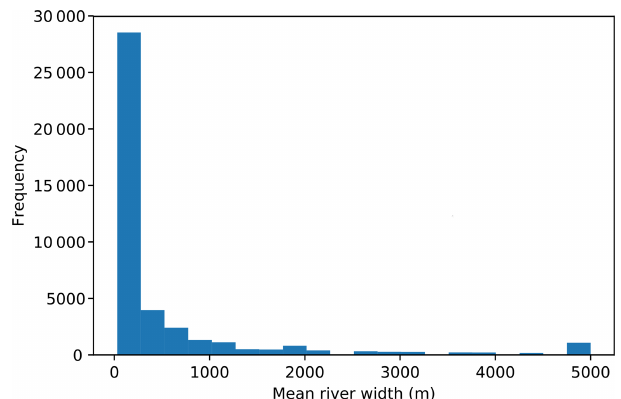
Figure 1. Distribution of mean river width taken from the Global River Widths from Landsat (GRWL) Database (Allen and Pavelsky,